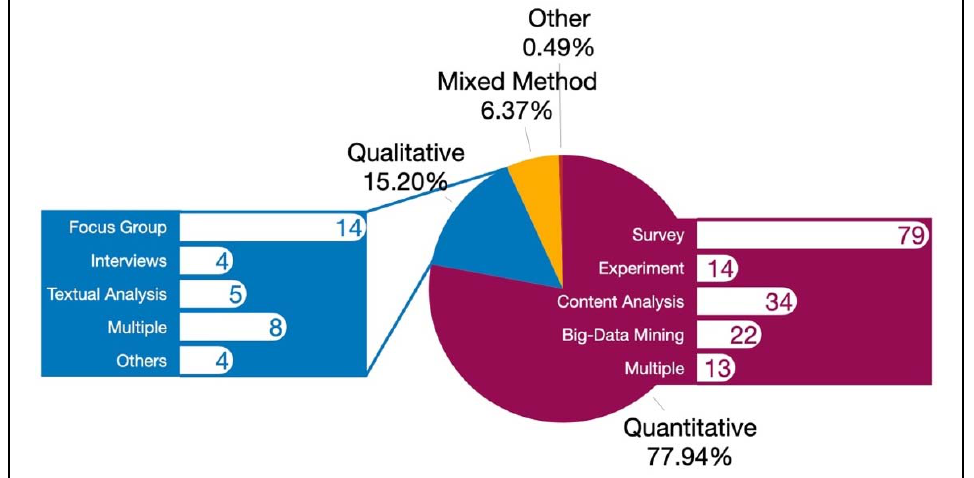
Figure 5. Frequency distribution of articles included in the systematic review, by research methodology.